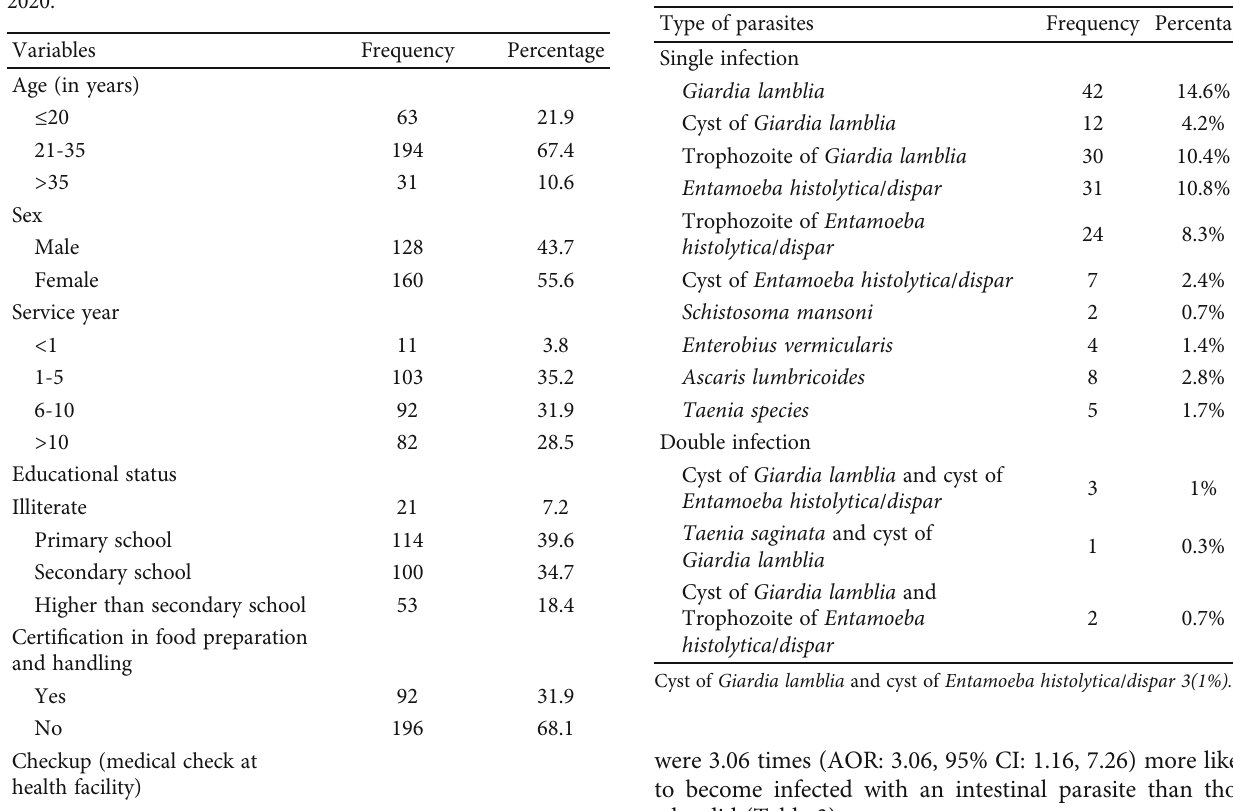
Table 1: Sociodemographic characteristics of food handlers ( N = 288 ) working in Goba town at food service establishments,